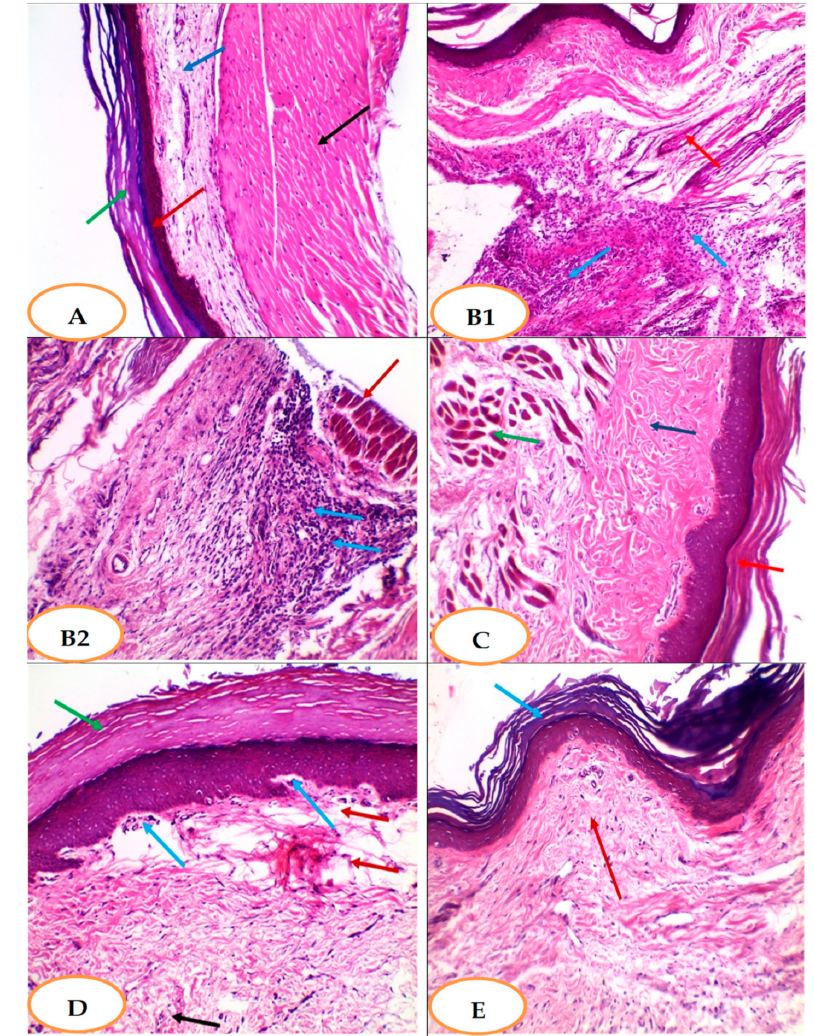
Figure 6. Effects of different treatments on histopathological examination of paw tissues. ( A ): Section in paw skin of the normal control group showed normal skin consisting of epidermis of average thickness (red arrow) lined with thick keratin (green arrow) and underlying normal dermis (blue arrow) and normal muscles (black arrow) [H&E × 100]. ( B1 ): section in paw tissue of Carrageenan group [positive control group] showed deep, dense dermal infiltration with chronic inflammatory cells (blue arrows) with congested vessel (red arrow) [H&E × 100]. ( B2 ): section in paw tissue of Carrageenan group [positive control group] showed severe interstitial inflammatory reaction (blue arrows) between muscle bundles (red arrow) [H&E × 200]. ( C ): section in paw tissue of celecoxib-50-treated group showed no inflammation. Muscles are normal (green arrow); however, the epidermis was thickened and covered with excessive keratosis (red arrow) with underlying excessive collagenosis (blue arrow) [H&E × 200]. ( D ): Section in paw tissue of YGME 100 showed superficial dermal mild chronic inflammation (blue arrows) with mild edema (red arrows) and mild vascular congestion (black arrow); the epidermis was covered with excessive keratosis (green arrow) [H&E × 200]. ( E ): Section in paw tissue of YGME 200 Group showed normal skin without inflammation or collagenosis, with normal epidermis lined with thick keratin (blue arrow) and dermis (red arrow) [H&E ×